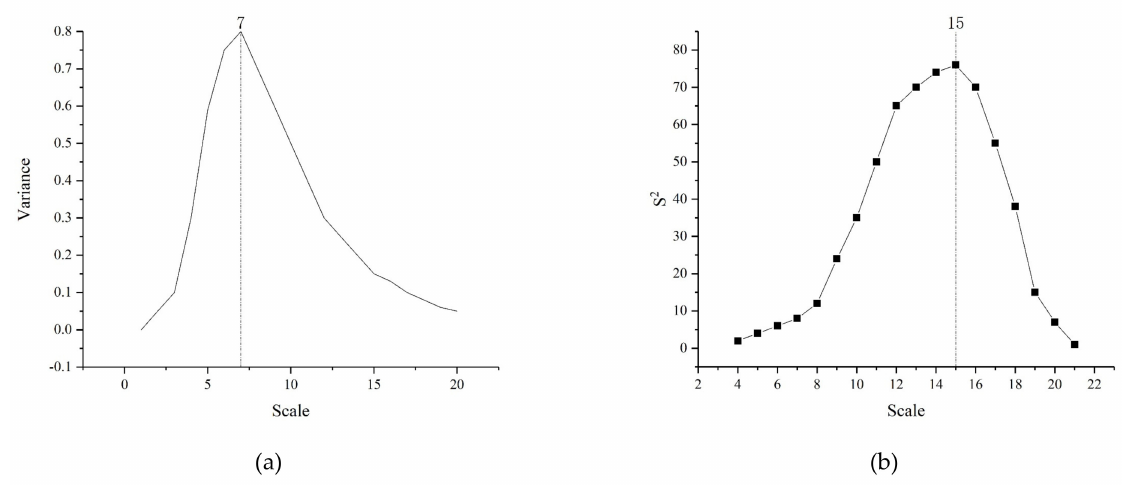
Figure 11. ( a ) Wavelet coefficient variance graph; ( b ) weighted average variance